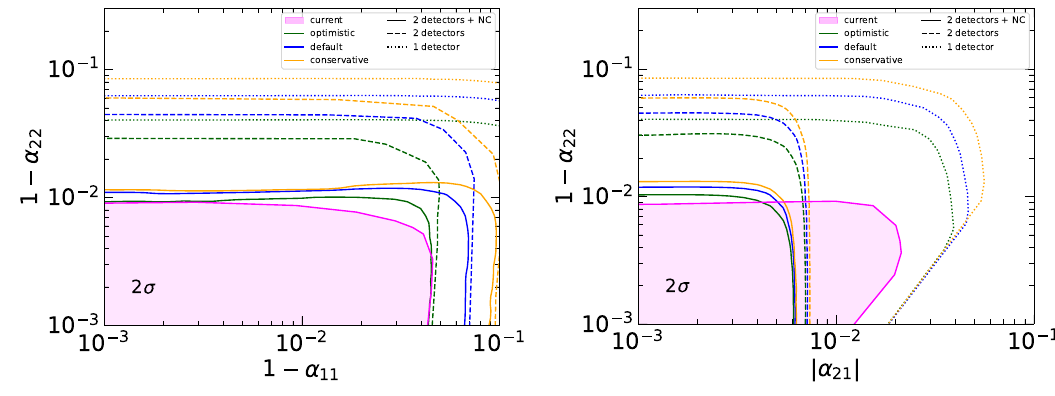
Figure 4 . The expected region in different planes of the nonunitarity α parameters at 2 σ for different choices of systematic uncertainties. Also shown are the current bounds taken from ref. [44].